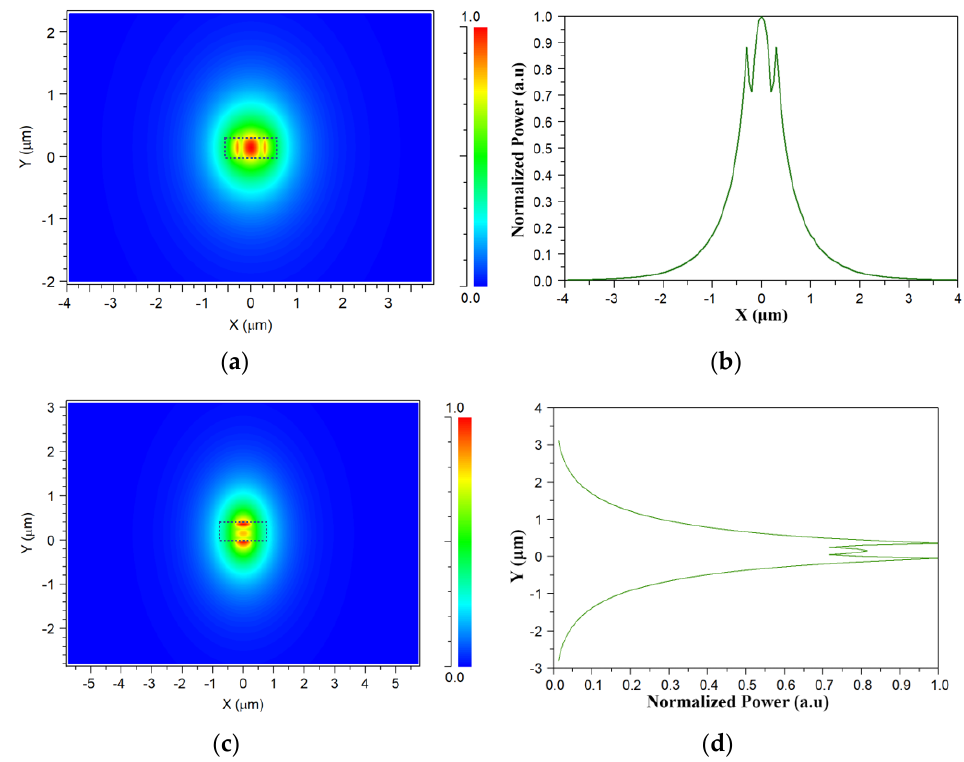
Figure 2. ( a ) The 1540 nm TE fundamental mode (SiN area in dotted rectangle) and ( b ) its horizontal view at Y = 0 .15 μm ; ( c ) The 1540 nm TM fundamental mode (SiN area in dotted rectangle) and ( d ) its vertical view at X = 0 μm.